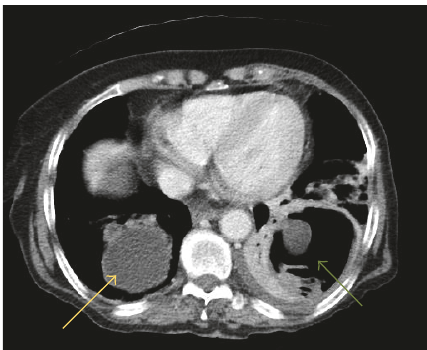
Figure 3: CT axial image shows a large cyst in the right lower lobe representing parenchymal hydatid cyst (yellow arrow); there is also a large cyst with air seen in the left lower lobe representing hydatid cyst in the left lung (green